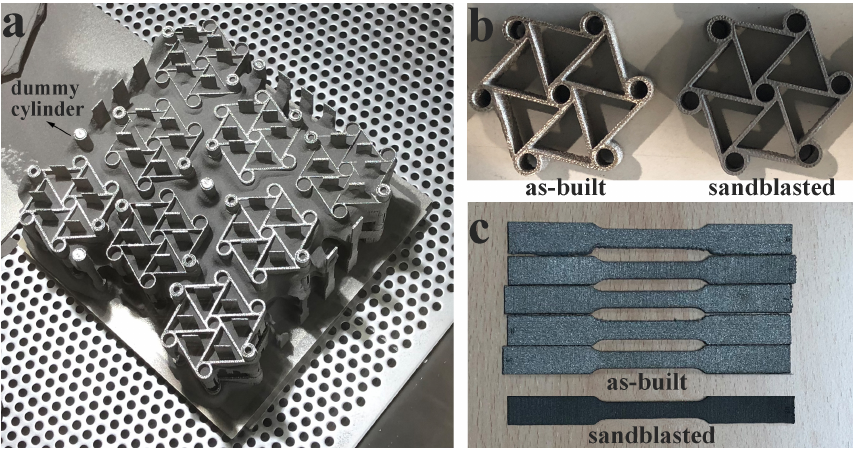
Figure 3. EBM printed parts: ( a ) printed parts in powder cake, ( b ) as-built and sandblasted chiral parts and ( c ) as-built and sandblasted tensile